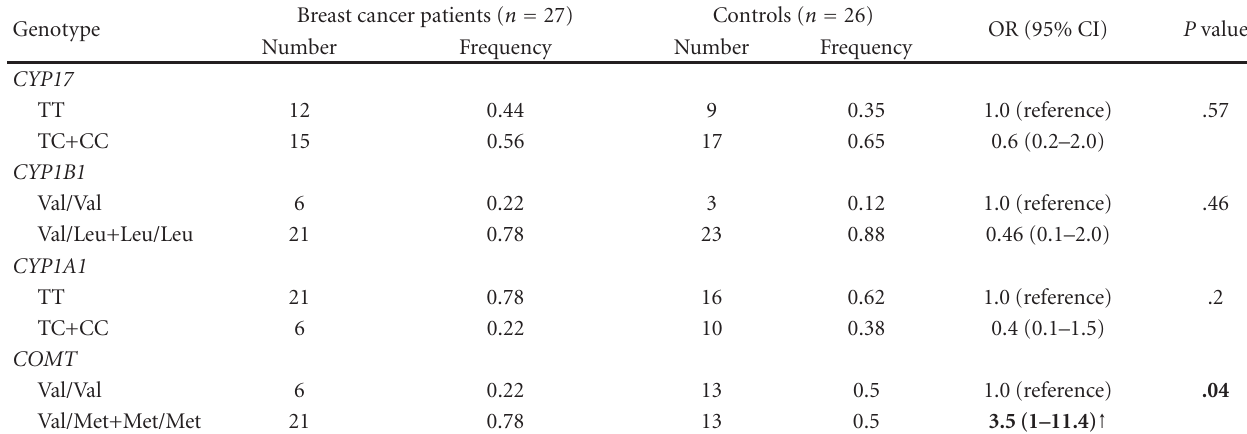
Table 4: Estrogen-metabolizing gene polymorphisms in breast cancer patients and controls with frequency of micronucleated cells higher than the mean of each group.